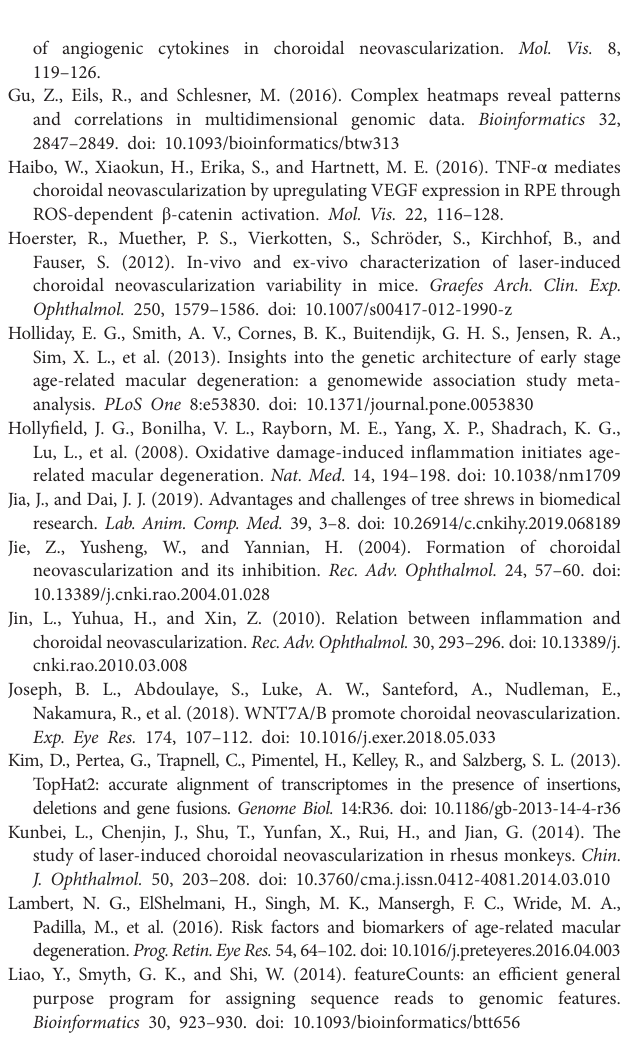
Supplementary Figure 1 | Symptoms of tree shrews with choroidal neovascularization (CNV) after laser photocoagulation. (A) Representative fundus angiograph of normal tree shrew. (B) Representative fundus angiograph of tree shrew with laser photocoagulation. (C,D) FFA/ICGA of normal tree shrew. (E,F) FFA/ICGA of tree shrew after 7 days of laser photocoagulation. (G,H) FFA/ICGA of tree shrew after 30 days of laser